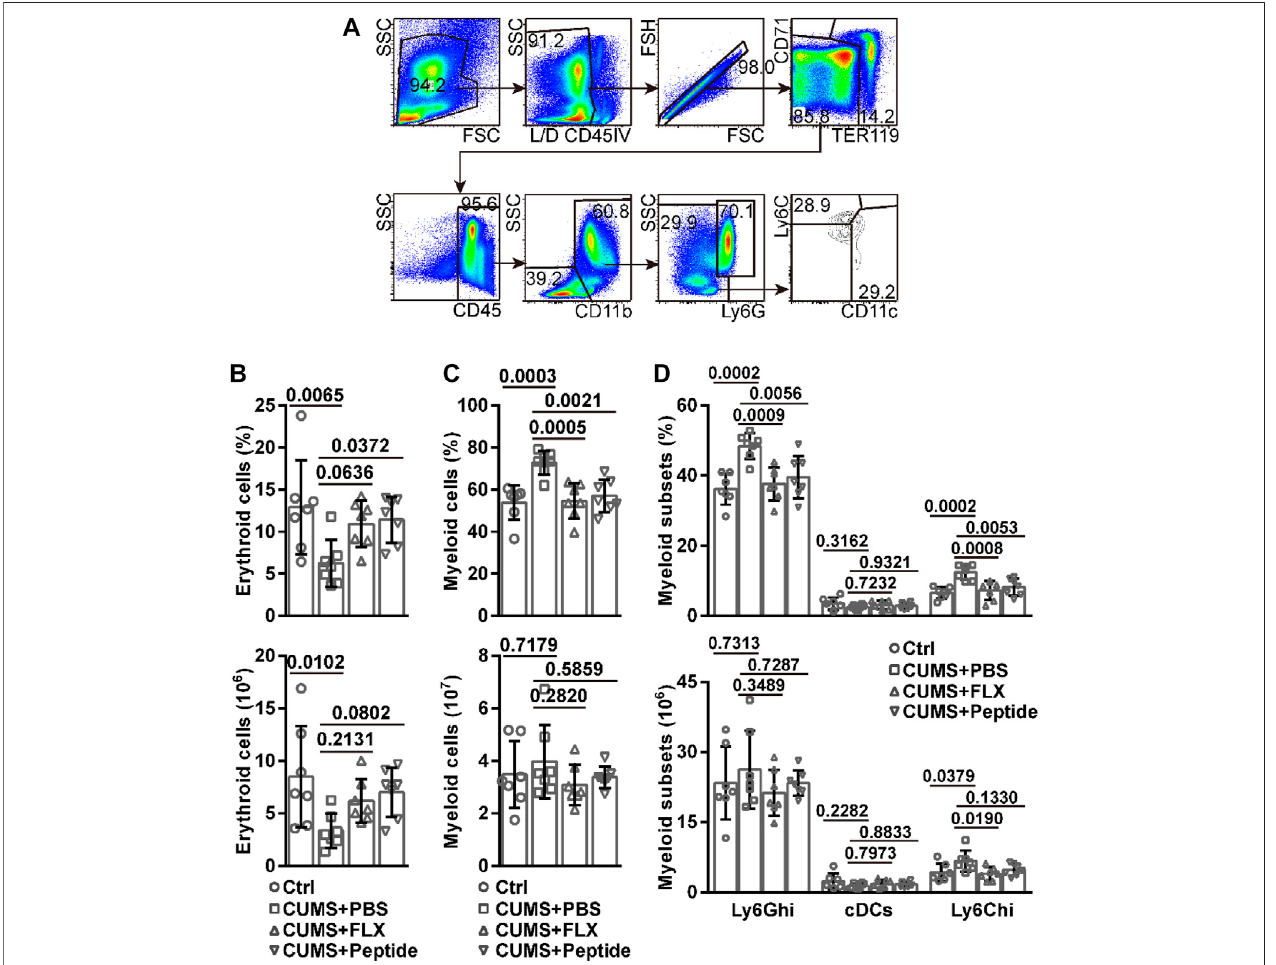
FIGURE 3 | ARA290 exhibited similar effects to fl uoxetine on bone marrow erythropoiesis and myelopoiesis in the CUMS mouse model: 8-week-old male C57BL/ 6micesubjectedtotheCUMSmodel( n =7micepergroup)weretreatedwith fl uoxetine(FLX)orARA290(peptide)daily.Thenbonemarrowcellsweresubjectedto fl ow cytometryanalysisoferythroidandmyeloidcells. (A) representativegatingstrategy. (B) thefrequencyandnumberofTer119 + orCD71 + erythroidcells. (C) thefrequency and number of CD45 + CD11b + myeloid cells. (D) the frequency and number of CD11b + CD11c − Ly6G hi neutrophils, CD11b + CD11c − Ly6C hi monocytes, and CD11b + CD11c + conventional dendritic cells (cDCs). The statistical values between different groups are shown.